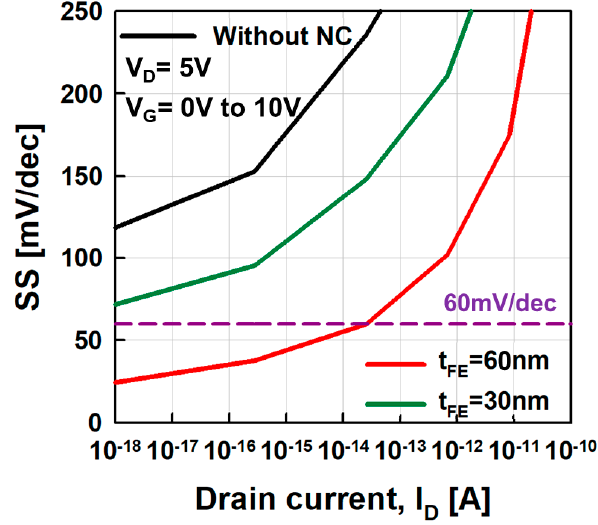
Figure 8. SS as a function of V G for different t FE (0 nm, 30 nm, and 60 nm).